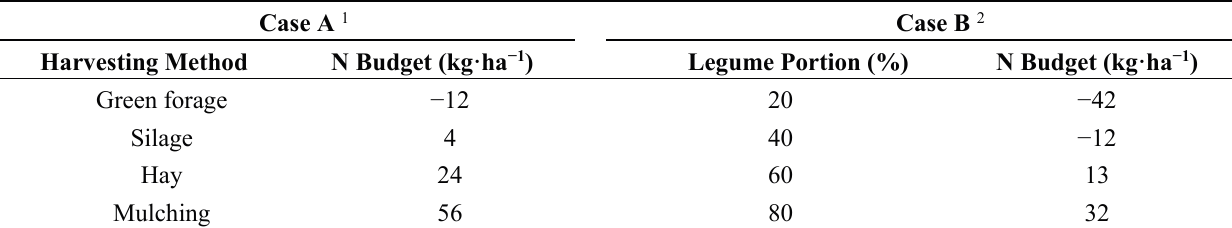
Table 3. Calculation of the nitrogen budget with the N budget calculator. Case A 1 Case B 2 Harvesting